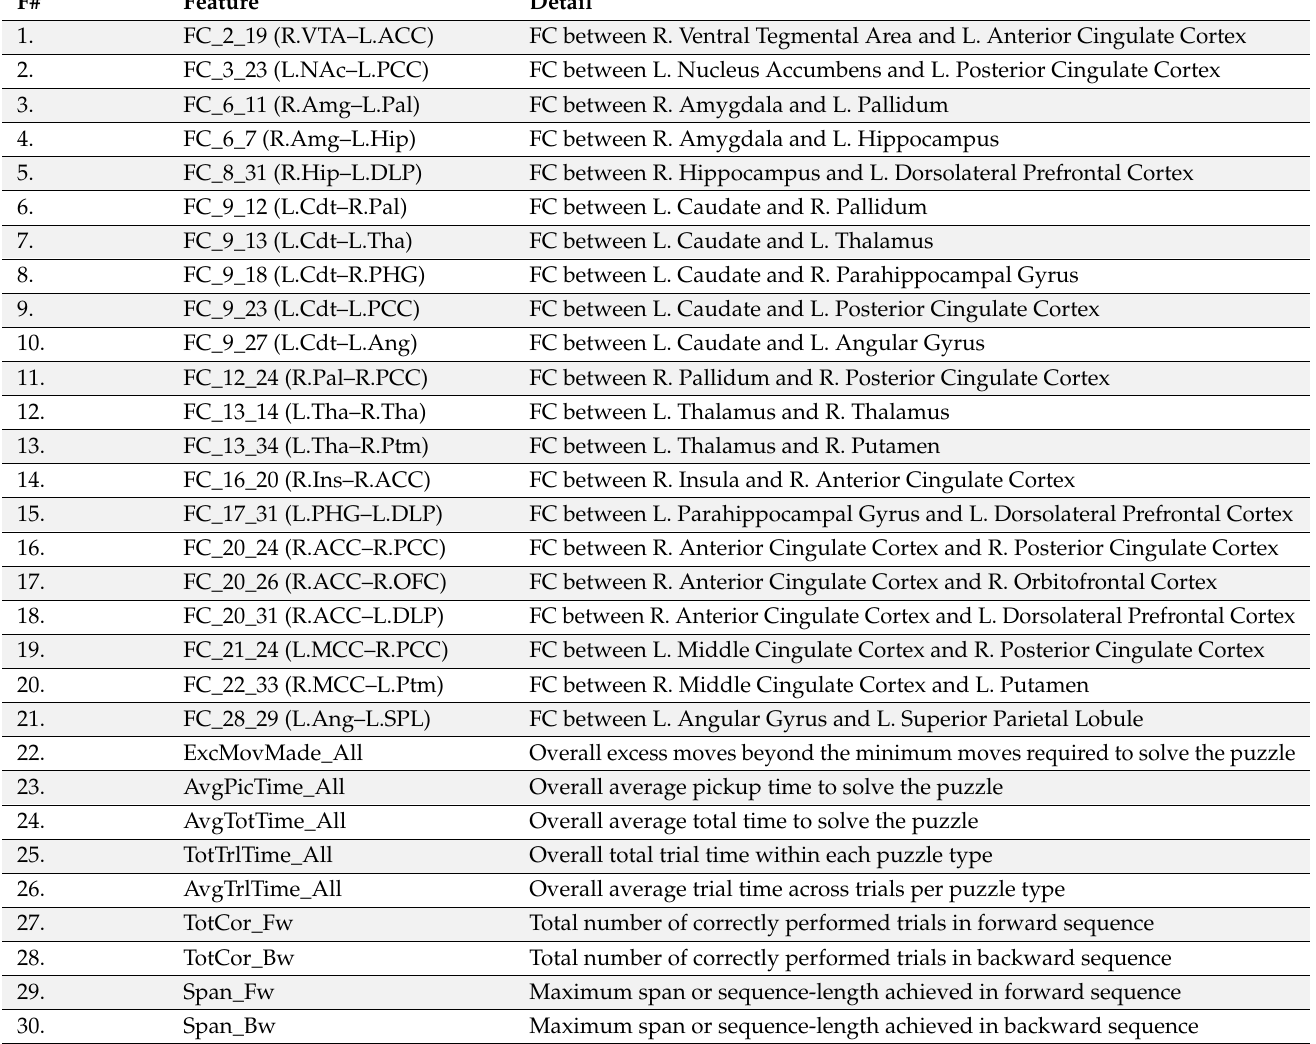
Table A1. List of features (F) included in the random forest classification model: (i) 21 reward network connections identified by the feature selection process (F1–F21), 13 neuropsychological scores involving 5 TOLT scores (F22–F26) and 8 VST scores (F27–F34), and 3 BIS scores